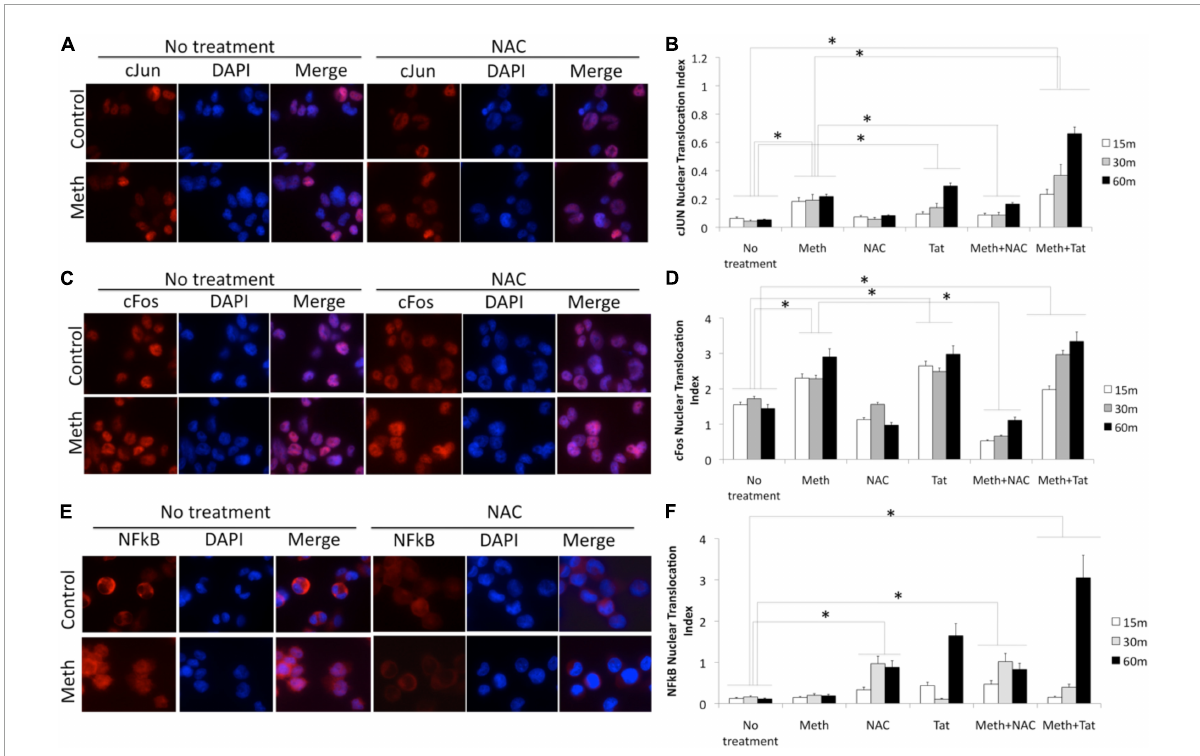
FIGURE10 Translocation of cJUN, cFOS and NFkB by Meth, effects of ROS and of Tat. Translocation was measured in THP1 cells stimulated with Meth (60 uM), Tat (10ng/ml) and/or NAC (1 uM), by immunocytochemistry using specific antibodies to pan-cJUN (A,B) , pan-cFOS (C,D) and NFkB p65 (E,F) , and a secondary AlexaFluor 594-conjugated antibody. Secondary antibody controls were negative (not shown). Representative immuno-cytochemistry in vehicle or Meth and/or NAC treatment, showing cJUN (A) cFOS (C) , and NFkB (E) . The nucleus was identified with DAPI staining. Translocation index was calculated for cells treated with Meth, and/or Tat, and/or NAC, 15, 30, and 60 min after stimulation, for detection of differences in the translocation of cJun (B) , cFos (D) and NFkB (F) . The index was obtained using measurement values obtained in Fiji ImageJ, in 5 images taken from each well, with all conditions performed in biological triplicates. * p < 0.05 in One-way ANOVA followed by Bonferroni’s